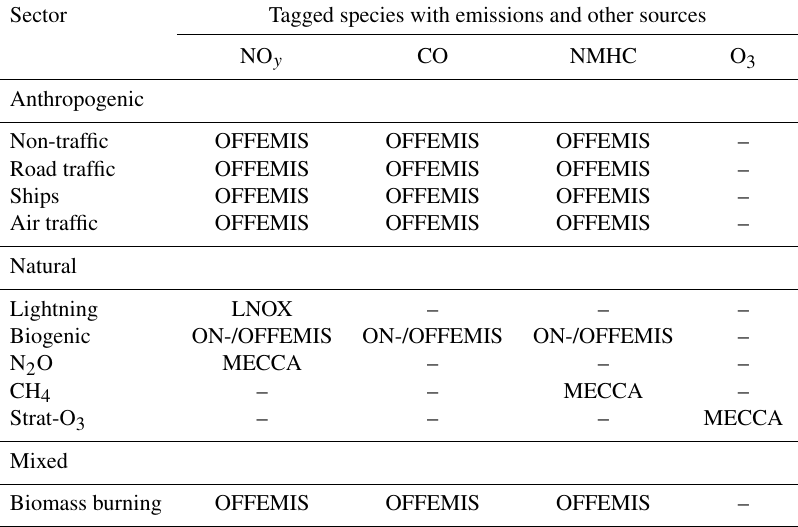
Table 2. Submodels that provide the source terms (emissions or production terms) for the individual emission sectors (first column) and tagged species (columns